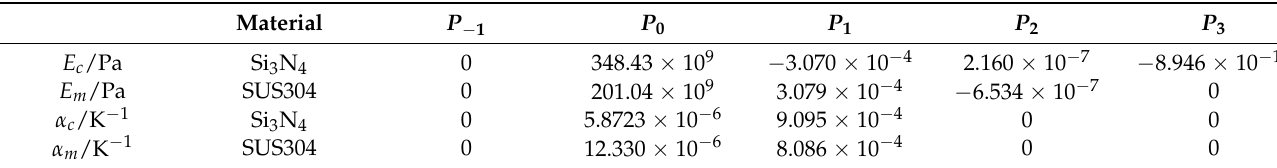
Table 2. Material coefficients of ceramics and